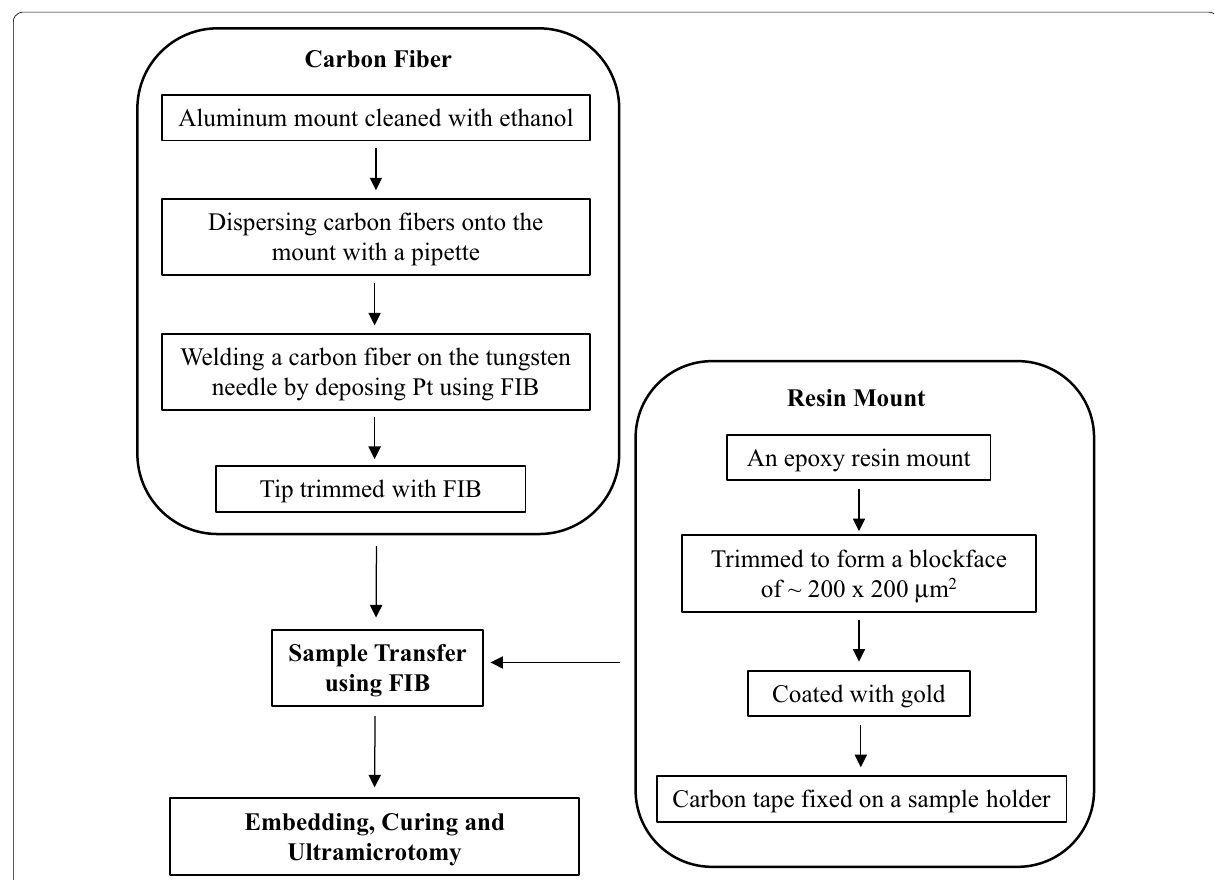
Fig. 1 The preparation procedure of the carbon fiber and resin